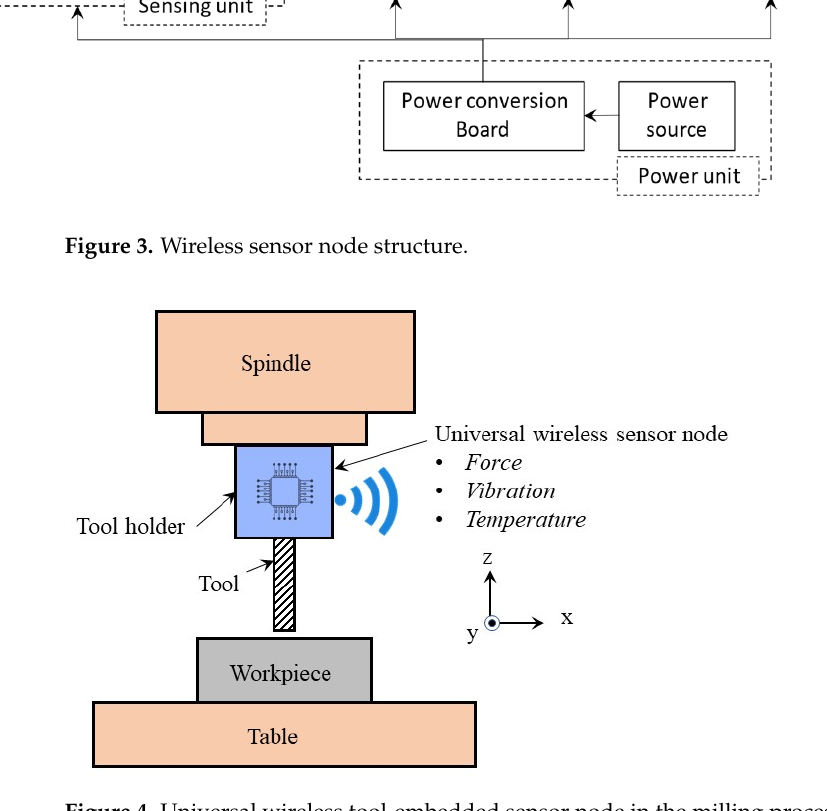
Figure 4. Universal wireless tool-embedded sensor node in the milling process.